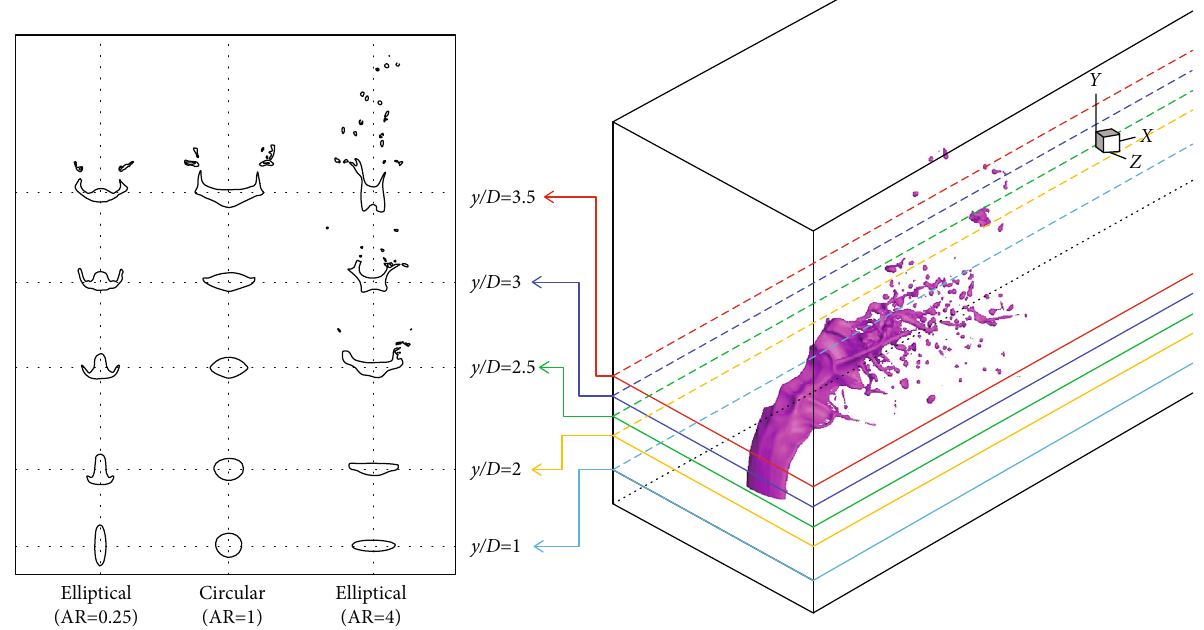
Figure 6: Cross-sectional shapes at y / D = 2 , 2.5, and 3 for Case 1, Case 3, and Case 5, respectively, t = 56 : 4 μ